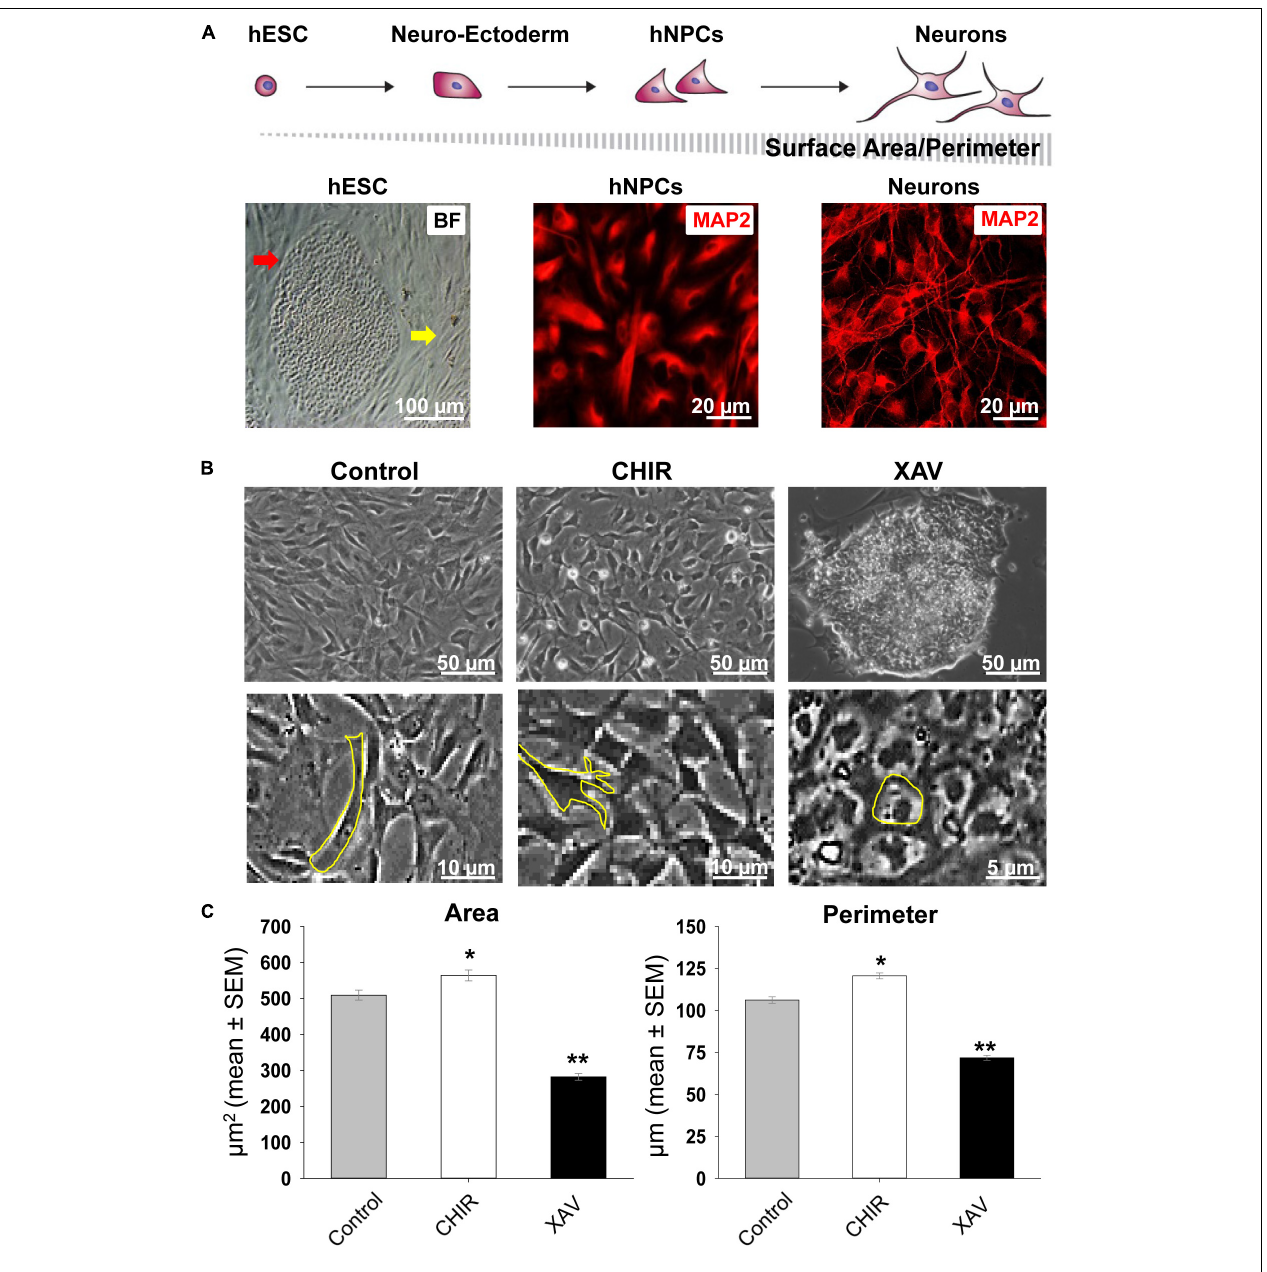
FIGURE 2 | Changes in neural morphology induced by Wnt modulators. (A) Top row: schematic presentation of the morphological changes in cells from undifferentiated hESCs to mature neurons during in vitro neural differentiation, and how they affect the relative change in surface area and perimeter. Bottom row , from left to right: bright field (BF) image of a single fixed undifferentiated HUES13-hESC colony (red arrow) surrounded by inactivated mouse embryonic fibroblasts (yellow arrow); immunofluorescence image of fixed hNPCs stained with MAP2 (red) and similar staining in mature neurons derived from HUES-13. (B) Top row: representative images of living cultures of HUES-64 hNPCs in control conditions (NIM + bFGF) and after 7 days of treatment with 3 µ M CHIR or XAV. Bottom row : magnified images exemplifying contour determination for the calculation of surface area and perimeter in morphological assays. (C) Quantification of soma area ( µ m 2 ) and cell perimeter ( µ m) of hNPCs (living cells, non-fixed) in control conditions (gray bars), and following treatment with 3 µ M CHIR (white bars) or XAV (black bars) for 7 days. Experiments were repeated three times in all 4 hNPC lines, 3 random fields were imaged in each experiment, > 50 cells were analyzed in each field. Values are mean ± SEM, * p < 0.05; ** p < 0.01, ANOVA.